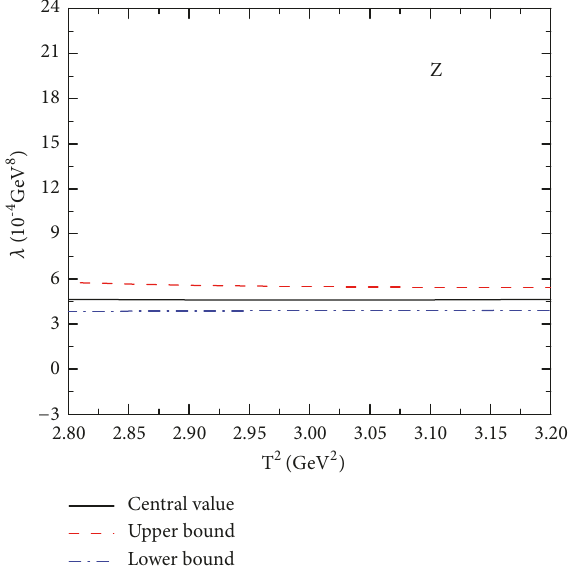
Figure 4: The pole residue with variation of the Borel parameters 𝑇 2